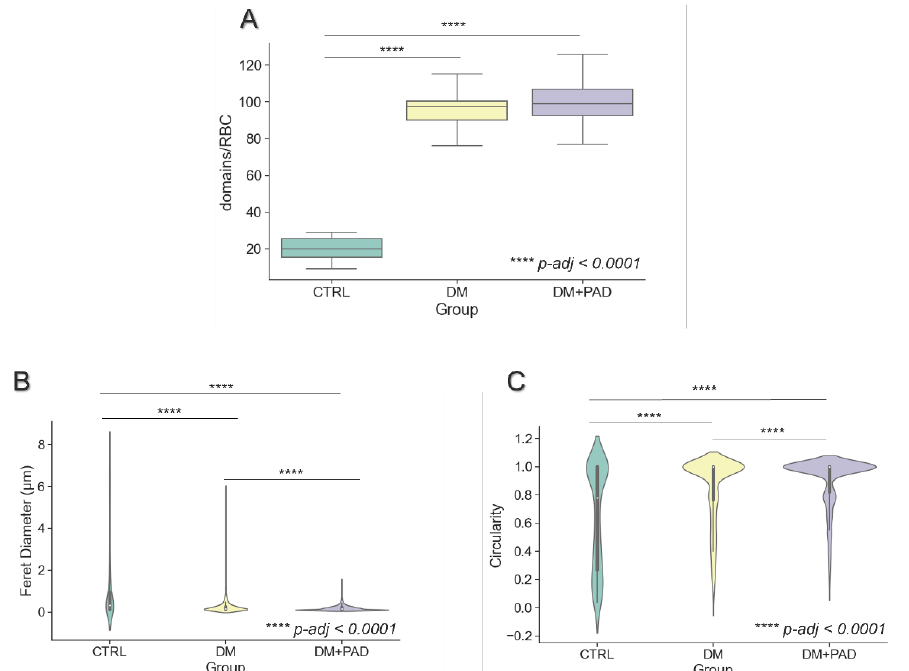
Figure 3. Quantitative analysis of LC domains in CTRL, DM, and DM+PAD RBC. ( A ) The box plot shows the distribution of number of LC domains calculated for 20 RBC of CTRL (on the leftm in green), DM (in the middle, in yellow), and DM+PAD (on the right, in purple). Mean values are comparable among diabetic subjects (95.4 ± 10.4 for DM and 100.1 ± 14.9 for DM+PAD, respectively, p -adj = 0.368), and they result significantly higher with respect to healthy controls (20.2 ± 6.4, p -adj < 0.0001). ( B ) The violin plot represents the distribution of LC domains Feret diameter (in µ m), evaluated for CTRL (in green), DM (in yellow), and DM+PAD (in purple) RBC. From the graph, a significant difference in LC domains size ( p -adj < 0.0001) among the three groups can be observed. In ( C ) the violin plot for domains’ circularity is reported for CTRL (in green), DM (in yellow) and DM+PAD (in purple), respectively. This analysis shows that LC domains in DM+PAD RBC are characterized by a higher circularity ( p -value < 0.0001), while a trend towards a more elongated shape can be retrieved in DM and CTRL subjects, respectively.